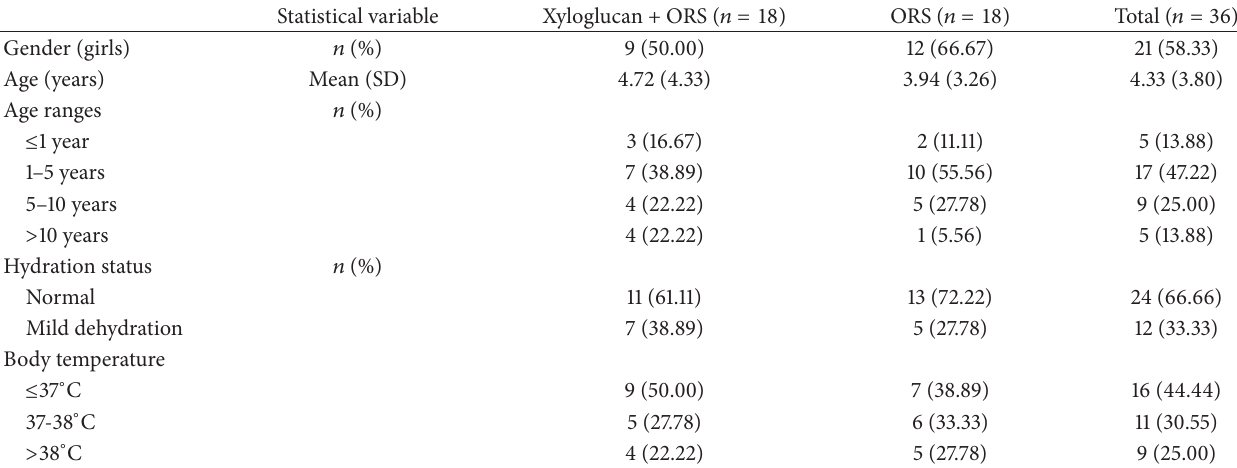
Table 1: Baseline demographic and clinical characteristics of